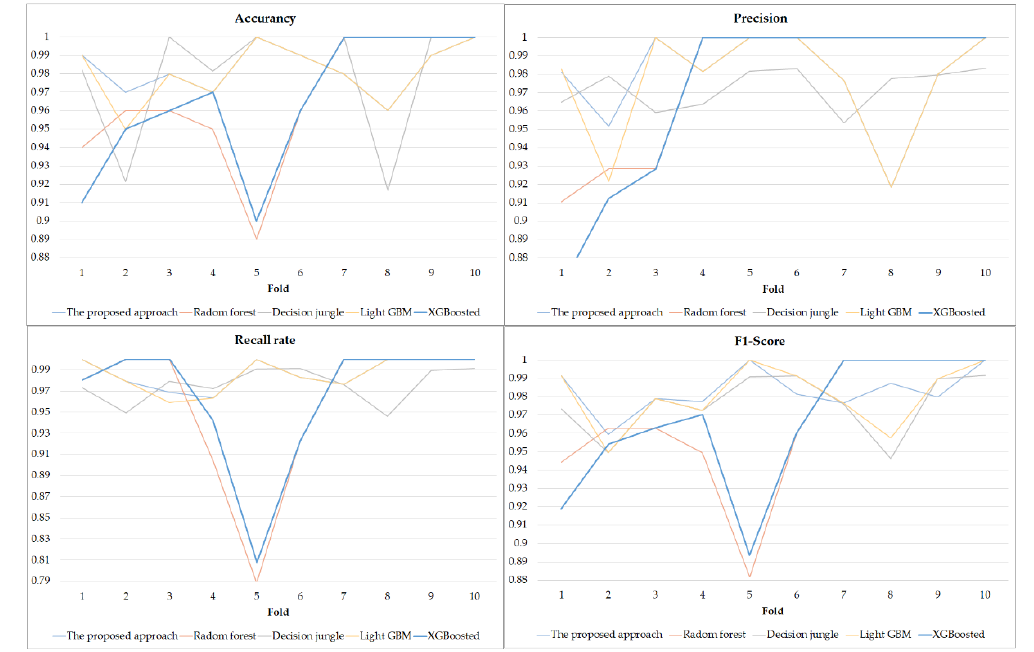
Figure 8. The results of 10-fold validation. Table 3. Results of mean and variance over repeated runs from 10-fold validation. Table 4. The overall results of the ensemble learning based